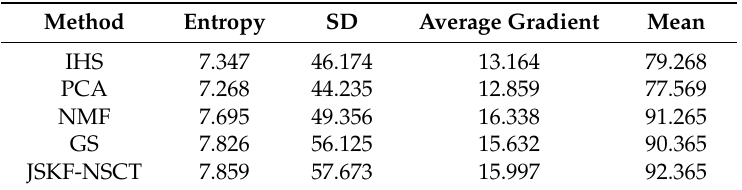
Table 5. Comparison of evaluation for five fusion methods for experiment A.